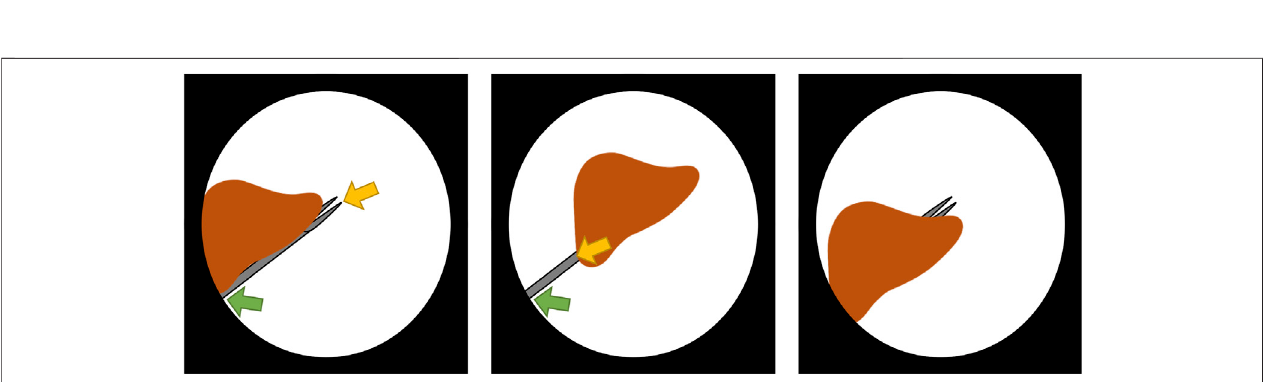
FIGURE 4 | Behaviour and limitations of the instrument localization pipeline in the presence of occlusions. The detected entrypoint and tooltip are indicated by the green and yellow arrow, respectively.In the partially occluded instrument (left), there isa visible path from entrypoint totip, therefore the instrumentis correctly detected. However,whenthetipisoccluded(center),thetooltip isdetectedtobeontheshaft.Iftheentrypointisoccluded(right),theinstrumentisnotdetected inthisstageofthe research as tools are expected to enter the scene from the boundary of the content area.